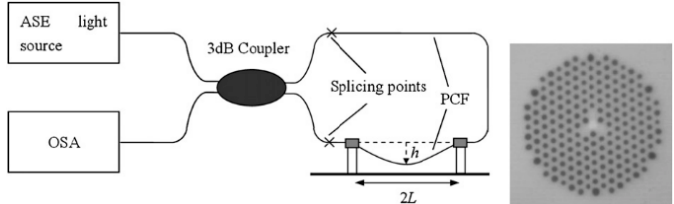
Figure 23. Demonstrated Sagnac loop using a low birefringence PCF for curvature measurement and the micrograph of that PCF (Reproduced from [84], with the permission of Elsevier publishing).